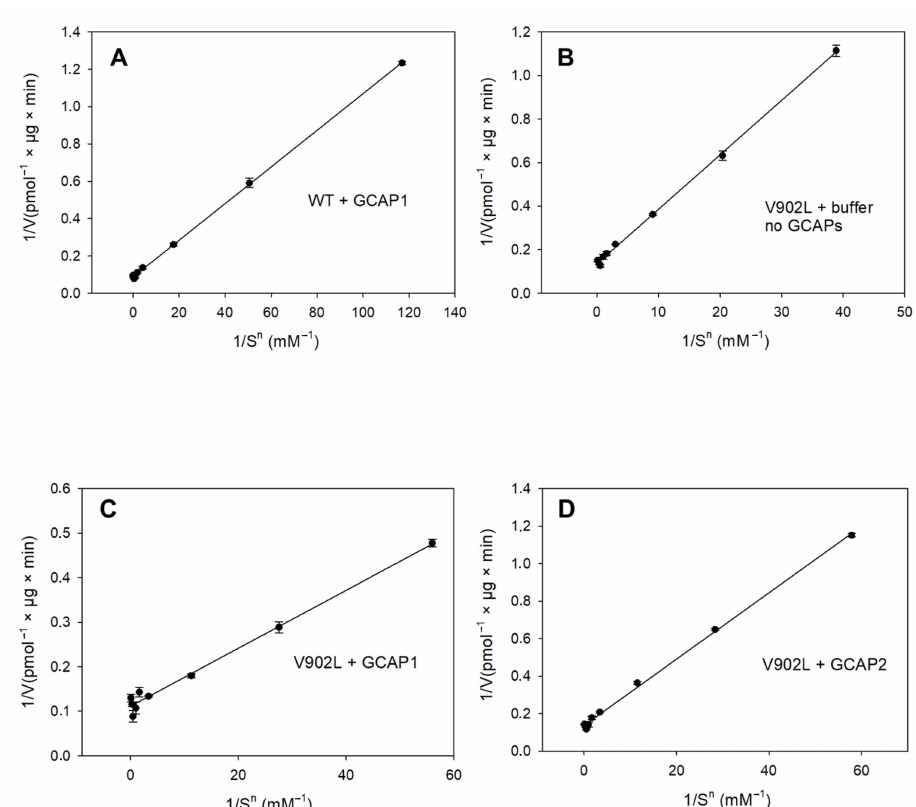
Figure 4. Lineweaver–Burk plot analysis of GC activities. GC-E variants were analyzed as indicated: WT GC-E in the presence of GCAP1 ( A ) and mutant V902L ( B ) in the absence of GCAPs. V902L mutant in the presence of GCAP1 ( C ) and GCAP2 ( D ). Reciprocal substrate GTP concentration 1/S is given in (mM − 1 ). Kinetics, as shown in Figure 3, showed deviations from an ideal Michaelis–Menten model. We linearized the plots by using apparent Hill coefficients of h = 2.07 (WT + GCAP1), h = 1.58 (V902L + buffer, no GCAPs), h = 1.75 (V902L + GCAP1), and h = 1.76 (V902L +